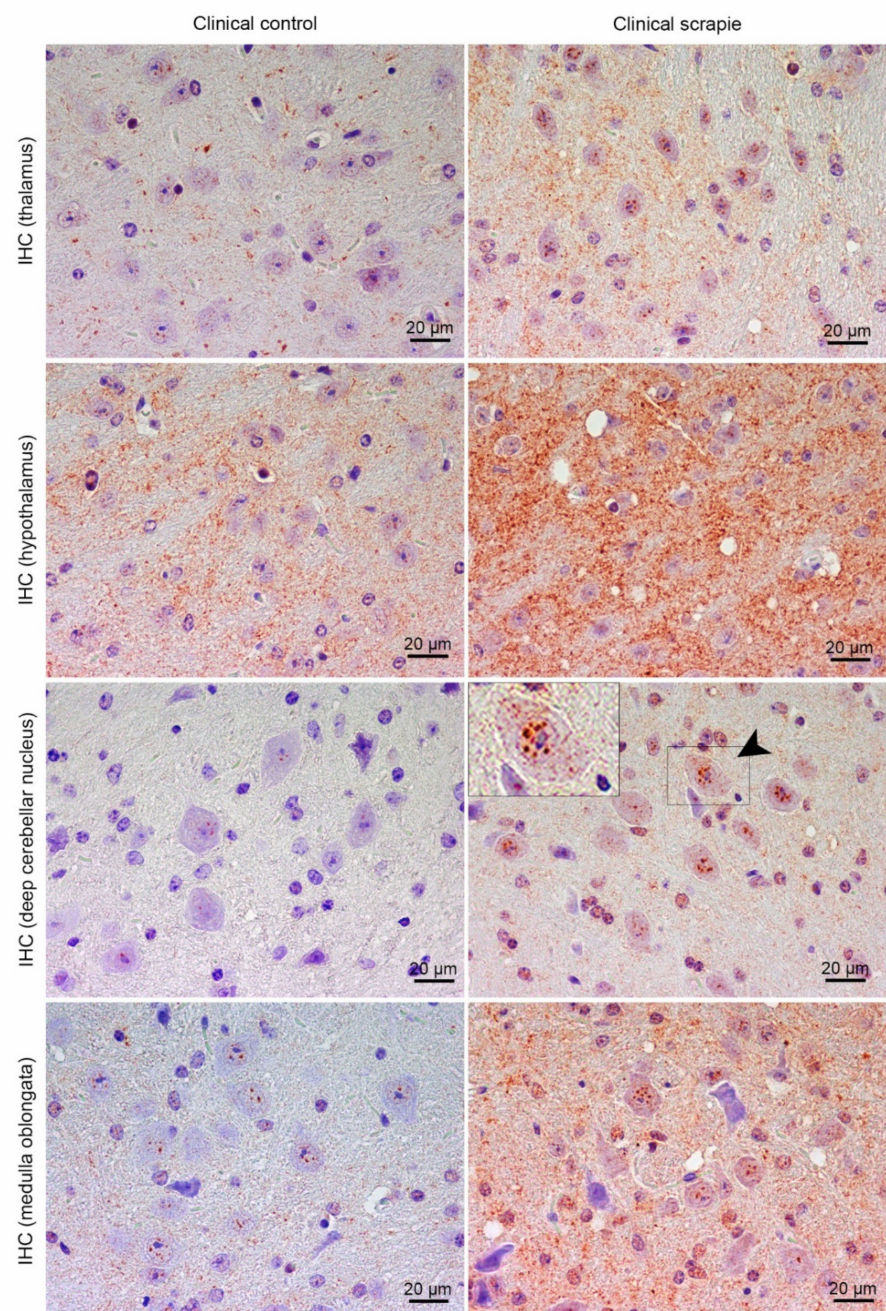
Figure 4. Immunostaining patterns of BAMBI in the central nervous system of scrapie-infected Tg338 mice. Figure shows representative images of BAMBI immunostaining in the thalamus, hypothalamus, deep cerebellar nucleus and medulla oblongata (20 µ m). Deposition type of BAMBI consisted of coarse granules found in the nuclei of cells, which were more evident in neurons of the thalamus, deep cerebellar nuclei of cerebellum (arrowhead and detail) and medulla oblongata. In addition, a di ff use neuropil staining was observed, remarkably strong in the hypothalamus but also present in the other brain regions